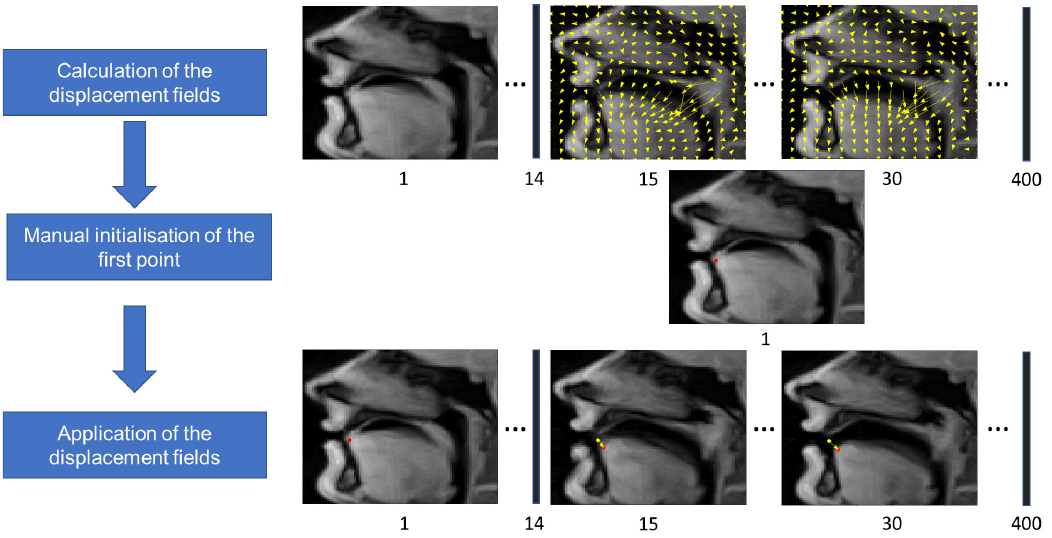
Figure 2. Scheme of the tongue tip tracking procedure illustrated with fragments of images for S1 acquired in the mid-sagittal plane. The yellow arrows show the displacement fields and the numbers under the images denote frame numbers. The red circles are the resulting points, and the yellow circles show the manually selected first point given for the